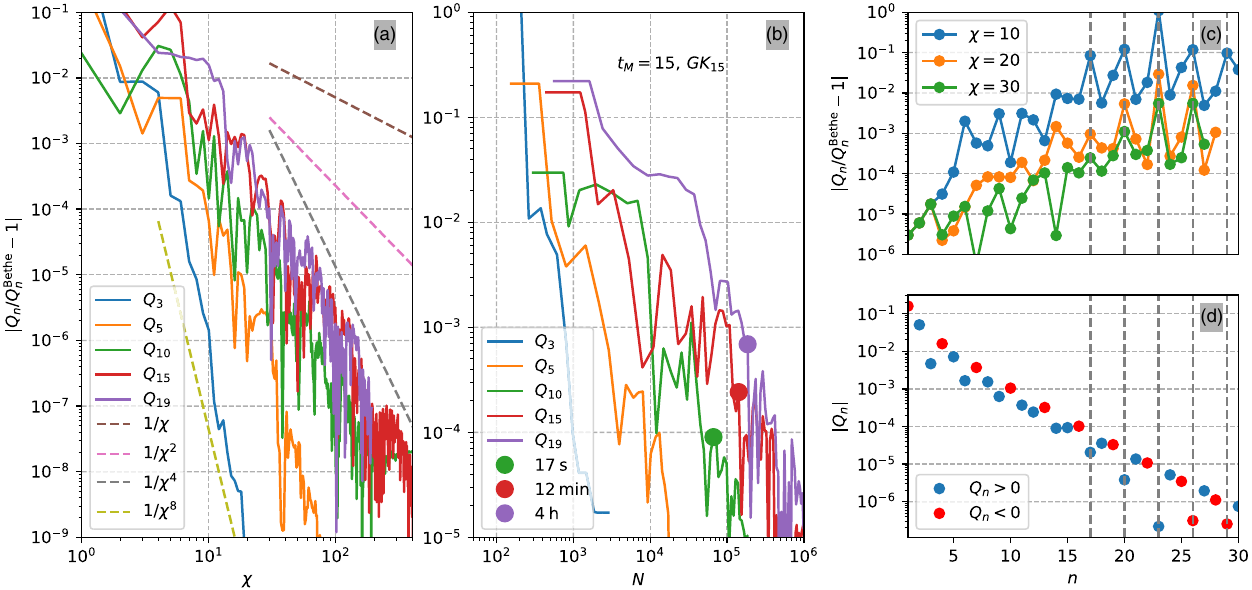
FIG. 9. Relative error of the coefficients Q with respect to the exact solution for n ¼ 3 (blue), n ¼ 5 (orange), n ¼ 10 (green), n ¼ 15 n (red), and n ¼ 19 (purple). All calculations are carried out using the env and alternate search variants of the algorithm. (a) Error versus tensor rank χ . Large values of t and d are used so that the accuracy is limited only by χ : t M 30 , GK 10 , n ¼ 15 , n ¼ 19 ) The dashed lines are guides to the eye for 1 = χ p scaling, which corresponds to ( n ¼ 5 ), and t 63 ( n ¼ M ¼ 1 =N p= 2 in terms of the number N of function calls. p ¼ 1 corresponds to Monte Carlo scaling. (b) Error versus N in a low-precision 15 and d ¼ 15 (GK calculation with t 15 ). The colored circles indicate the CPU time of the calculation when performed on a single M ¼ core. (c) Error versus n for χ ¼ 10 (blue), χ ¼ 20 (orange), and χ ¼ 30 (green) ( t positive and negative coefficients. The vertical lines indicate values of n where j Q